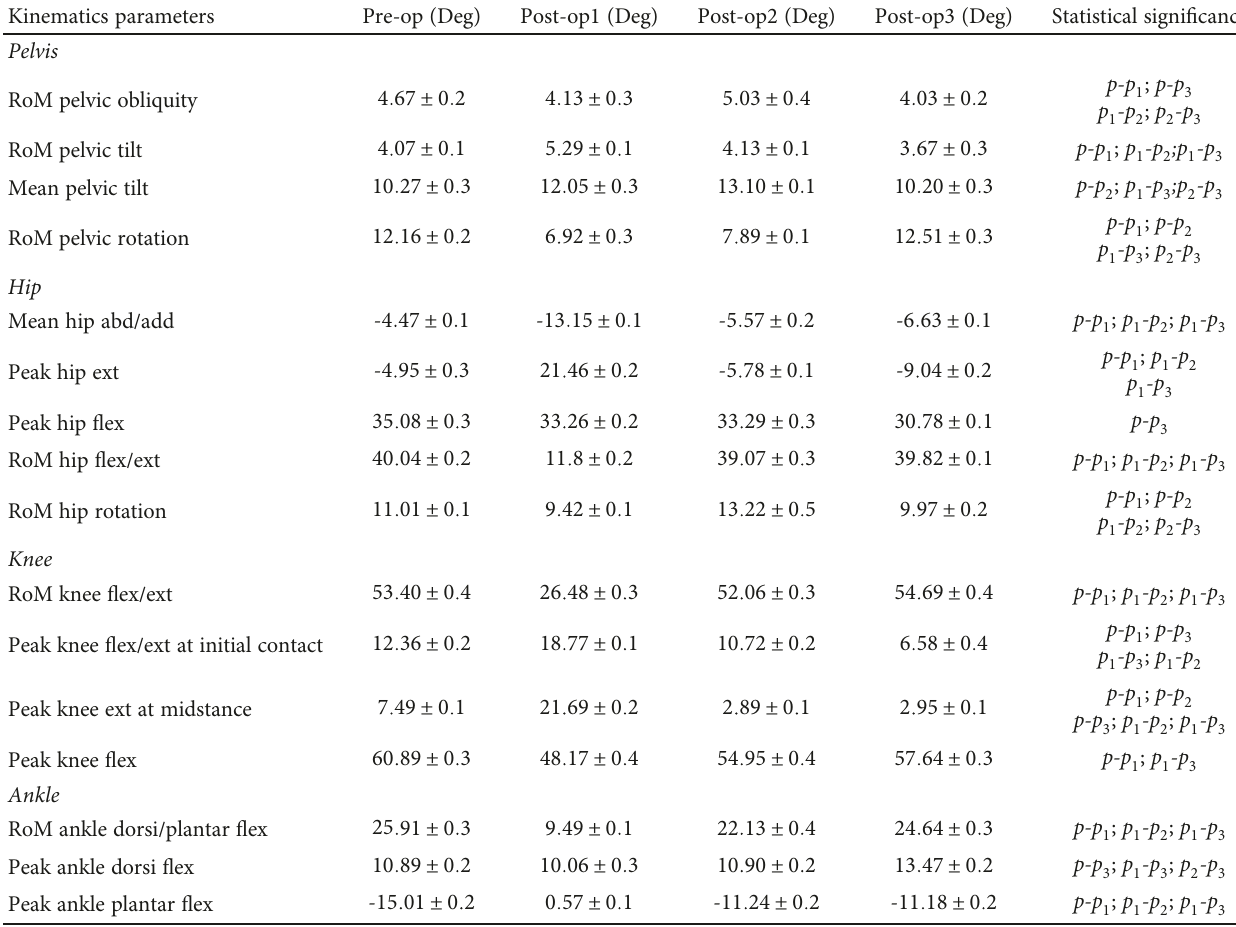
Table 2: Mean ( ± standard deviation) values of kinematic gait parameters obtained during pre-op, post-op1, post-op2, and post-op3 periods. Kinematics